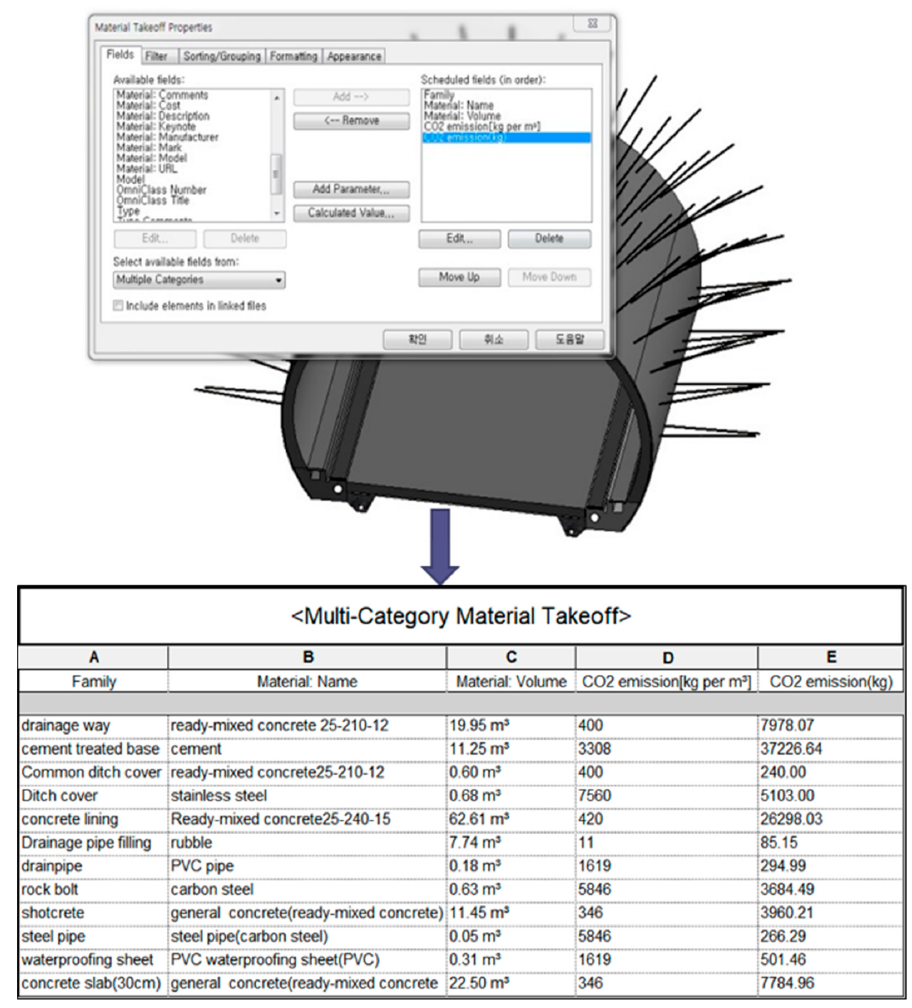
Figure 7. The materials quantity and CO 2 emission. Appl. Sci. 2020 , 10 , x FOR PEER REVIEW